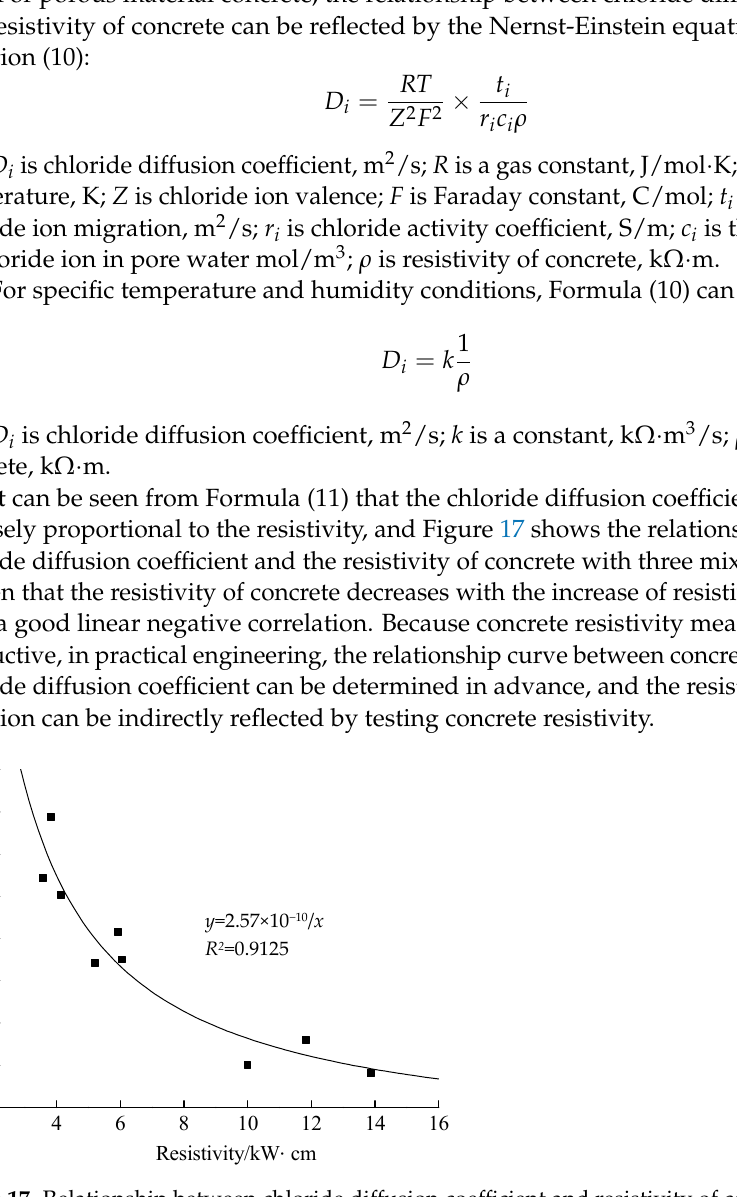
Figure 16. The resistivity of concrete by four-probe method.